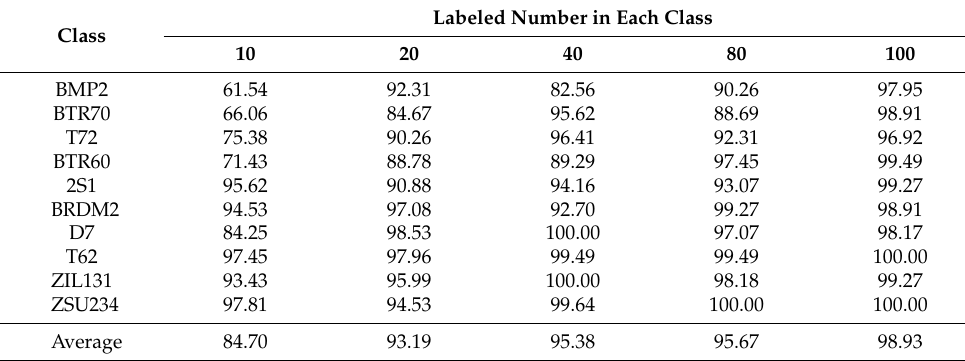
Table 11. Recognition accuracy (%) with automatic